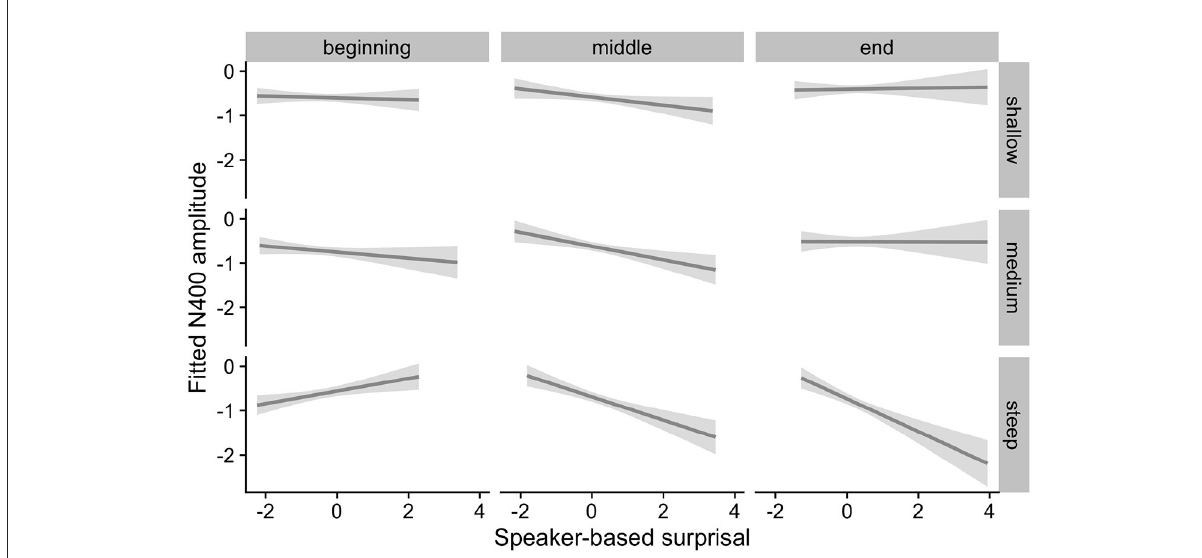
FIGURE7 Effects of aperiodic (1/f) Slope on changes in the relationship between speaker-based surprisal (z-transformed) and N400 amplitude over the course of Experiment 2. The figure visualizes partial effects as calculated using the remef package, adjusted for Prestimulus Amplitude and Canonicity. Note that position in the experiment (operationalised via epoch in the statistical model) is trichotomised into beginning, middle and end for visualization purposes only; epoch was included in the model as a continuous predictor. The same holds for the individual differences variables, which are trichotomised for visualization purposes but were entered into the statistical models as a continuous predictors. Shaded areas indicate 95% confidence intervals.